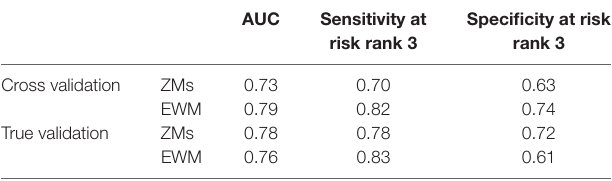
TaBle 3 | Summary of co-kriging model validations for the probability of zebra mussel (ZM) and Eurasian watermilfoil (EWM) introductions in Minnesota.